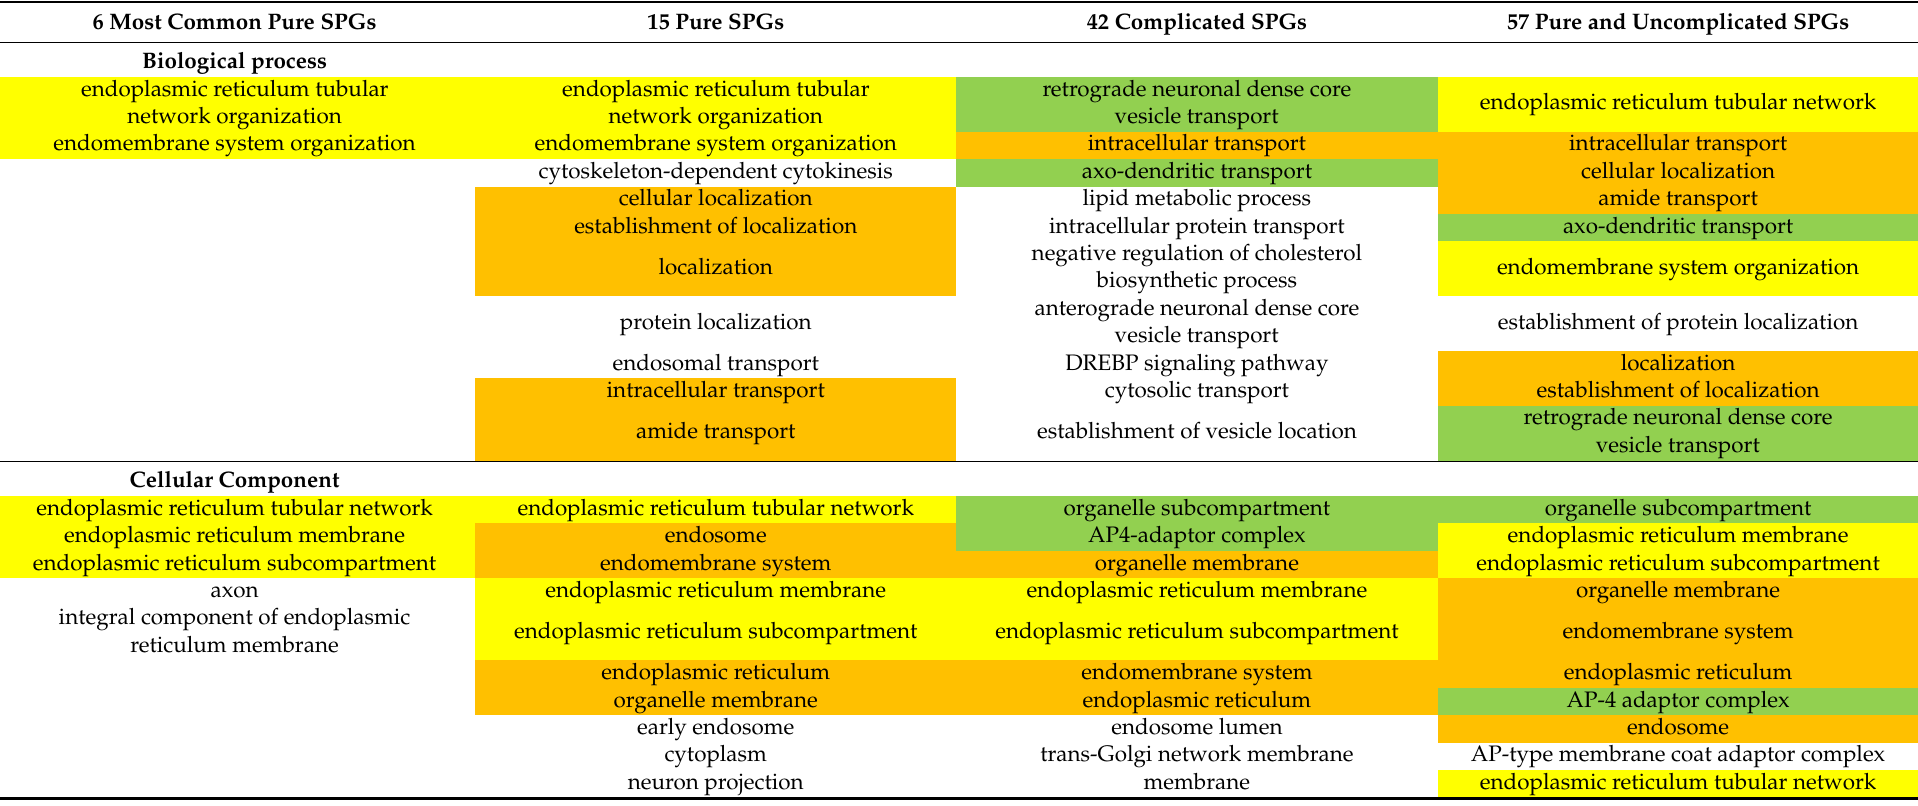
Table 2. Gene Ontology (GO) terms of protein–protein interactions (PPIs) of direct interactions (top ranked by false discovery rate,